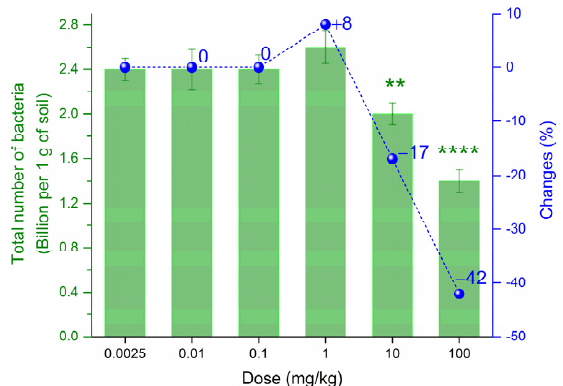
Figure 3. Effect of PtNPs on the total number of bacteria in Haplic Cambisols Eutric with its relative changes compared to the control. (** p ≤ 0.01, **** p ≤ 0.0001).